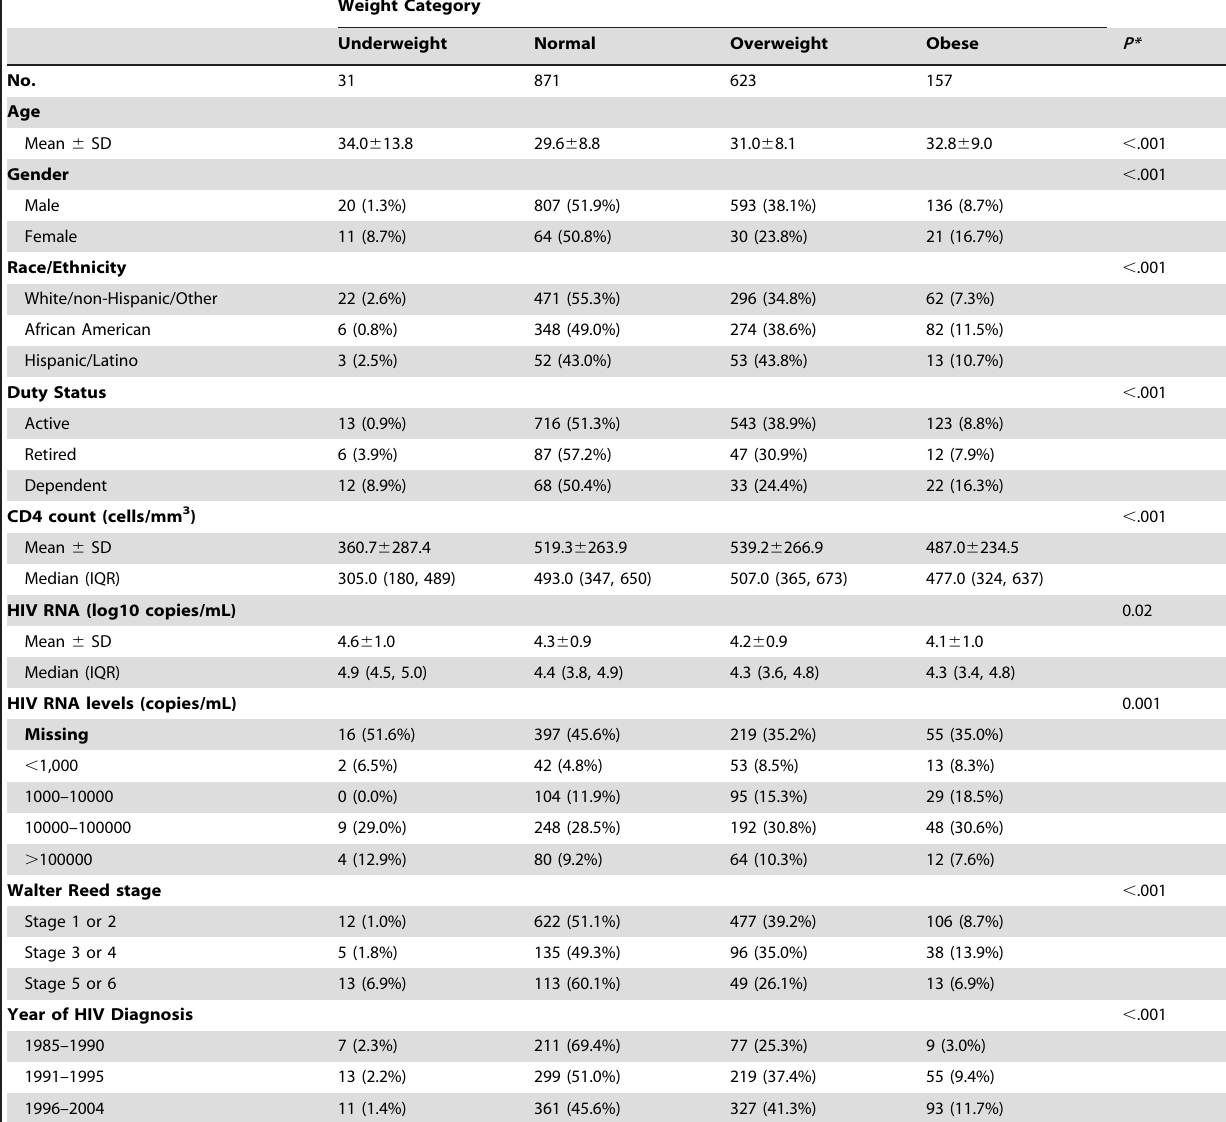
Table 1. Baseline Characteristics by Weight